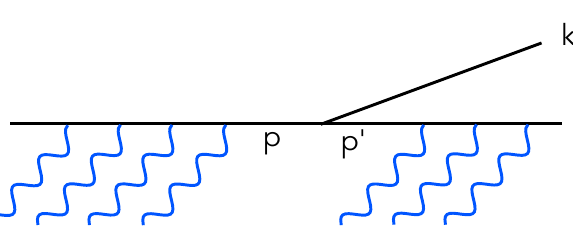
Figure 2. Scattering amplitudes involving excited strings, such as the one shown in figure 1, are most effectively computed from amplitudes involving exclusively tachyons and photons, with the excited strings appearing as intermediate